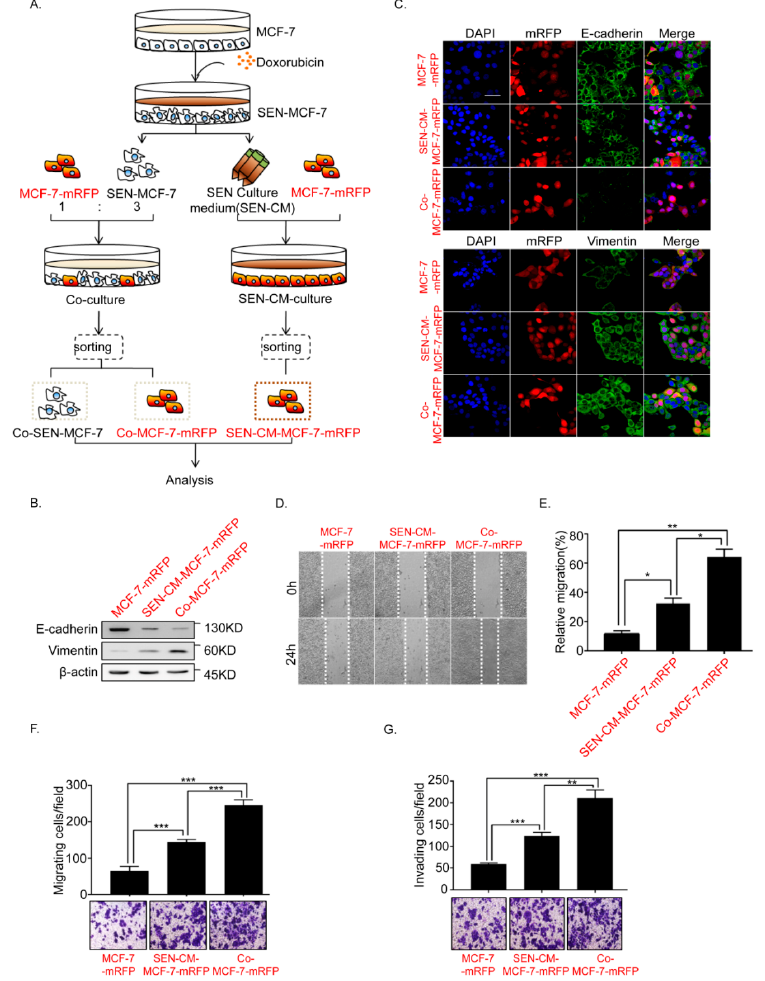
Figure 1. Doxorubicin (Dox)-induced MCF-7 cell senescence promoted the epithelial–mesenchymal transition (EMT) of adjacent breast cancer cells. ( A ) Schematic diagram showing the experimental setup. Schematic diagram of the co-culture systems. Senescent MCF-7 cells (SEN-MCF-7) induced by Dox (200nM) were co-cultured with MCF-7-mRFP at a 3:1 ratio (SEN-MCF-7:MCF7-mRFP). Senescent MCF-7 cells (SEN-MCF-7) were recovered from the supernatant and mixed with normal medium at a 3:1 ratio (senescence supernatant: normal medium) as conditional medium (SEN- CM) for MCF7-mRFP cell monocultures. Red and black letters, used to distinguish two types of MCF-7 cells. Red letters: MCF-7 cells fused to red fluorescent protein, mRFP. Black letters: MCF- 7 cells without fusing to mRFP. ( B ) Immunoblot analysis of protein expression of the epithelial marker E-cadherin and mesenchymal marker Vimentin in MCF-7-mRFP cells with the indicated treatments. ( C ) Immunofluorescence staining for EMT markers in MCF-7-mRFP cells with the indicated treatments. Scale bar, 50 µ m. ( D , E ) Wound-healing assay of MCF-7-mRFP cells with the indicated treatments. ( D ) Representative micrographs of wound-healing assay are shown. ( E ) Data represent the relative migration ratio of cells per field (error bars indicate mean SD, n = 3 experimental replicates, * p < 0.05, ** p < 0.01, *** p < 0.001). ( F ) Migration assay of MCF-7-mRFP cells with the indicated treatments. Representative micrographs of the migrated cells are shown. Data represent the number of cells derived from mean cell counts of five fields (Error bars indicate mean SD, n = 3 experimental replicates, * p < 0.05, ** p < 0.01, *** p < 0.001). ( G ) Invasion assay of MCF-7-mRFP cells with the indicated treatments. Representative micrographs of the migrated cells are shown. Data represent the number of cells derived from mean cell counts of five fields (Error bars indicate mean SD, n = 3 experimental replicates, * p < 0.05, ** p < 0.01, *** p <